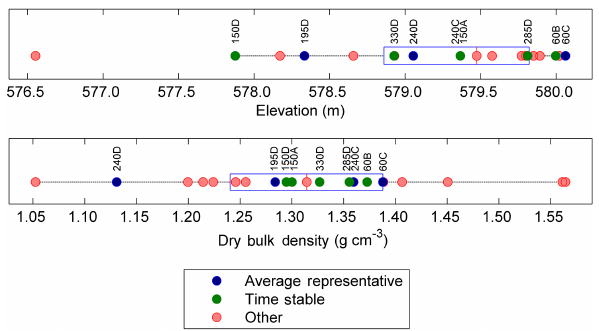
Figure 6. Physical characteristics of the time-stable and average representative sites. The boxplot indicates the median (red line), 25th and 75th percentile (edges of the box), and minimum and max- imum (extent of whiskers) values of all point measurement loca- tions.